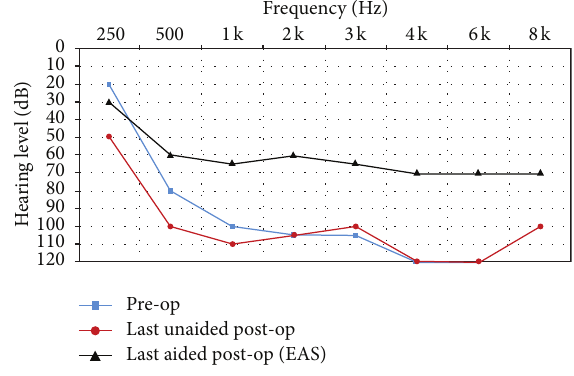
Figure 5: Audiometric results for Subject 5.